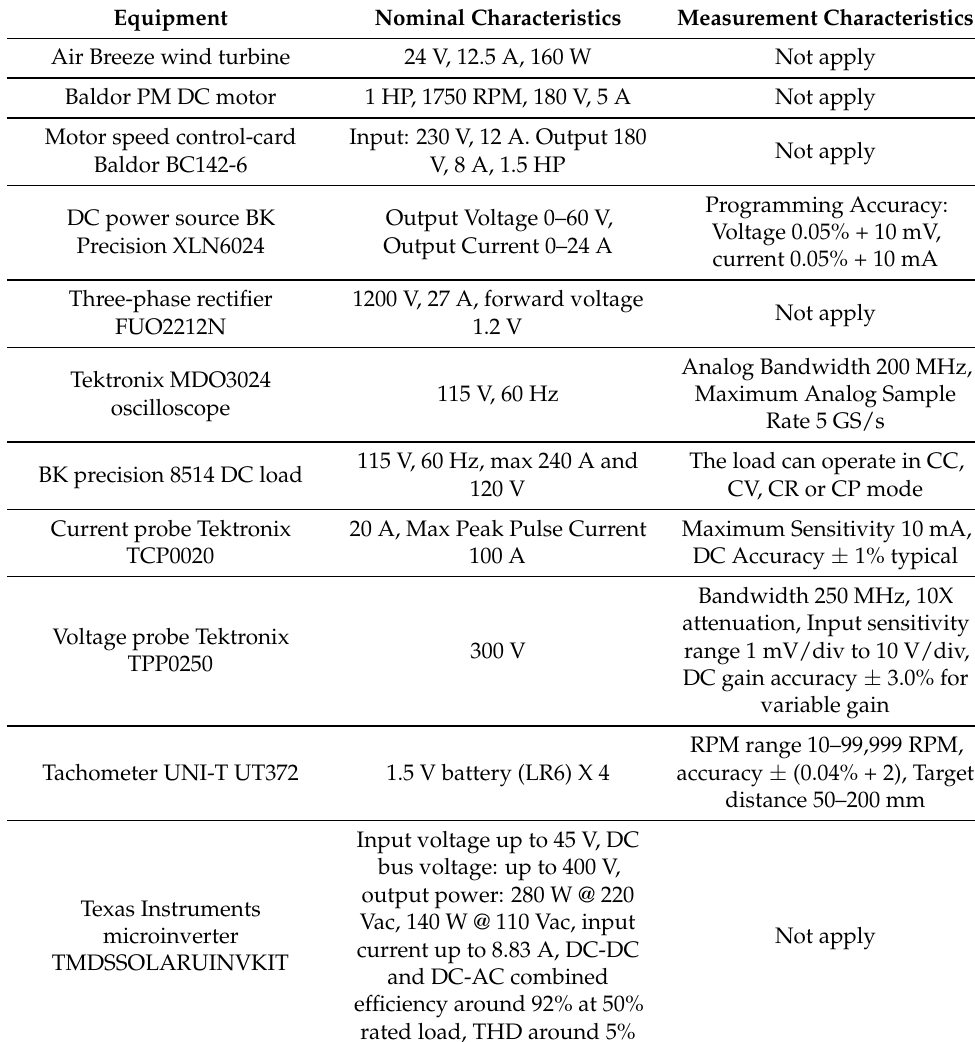
Table A1. Test and measurement equipment